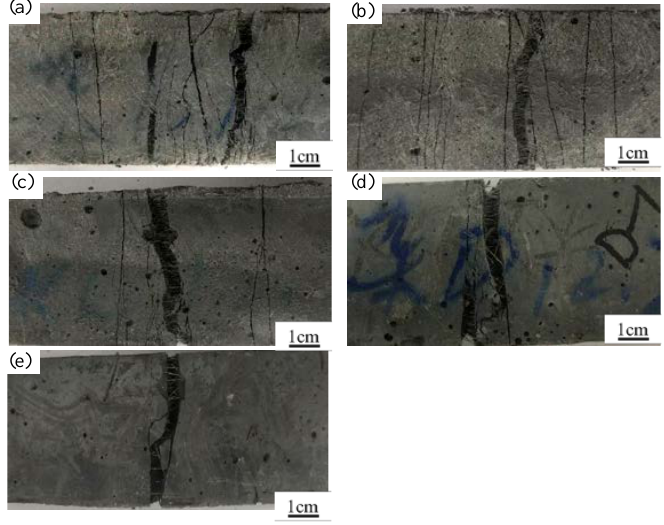
Figure 13. Multiple cracking of HUHP-ECCs. ( a ) HUHP-2.0-0; ( b ) HUHP-1.5-0.5; ( c ) HUHP-1.0-1.0; ( d ) HUHP-0.5-1.5; ( e ) HUHP-0-2.0.